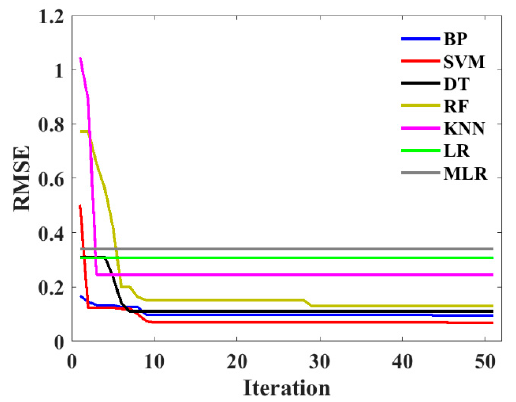
Figure 5. Root-mean-square error (RMSE) versus iterations.